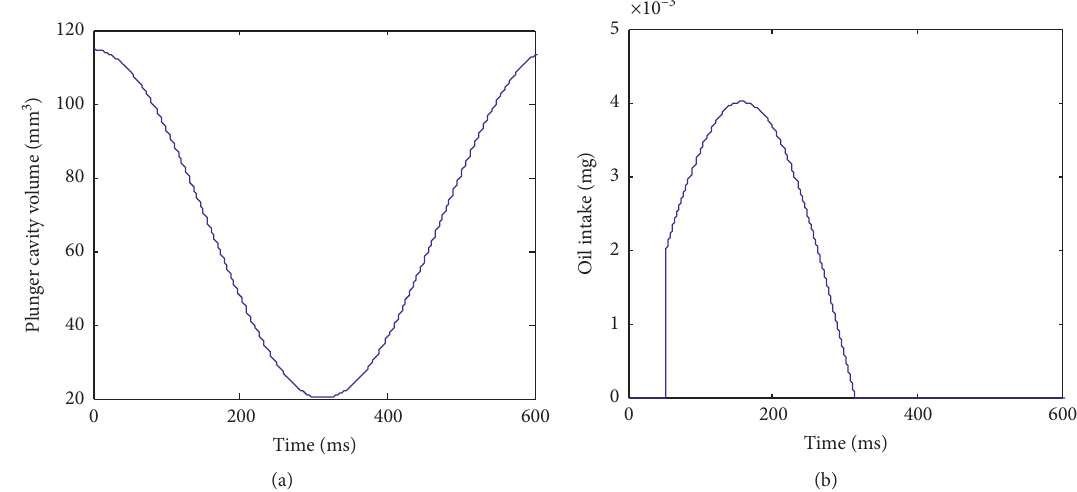
Figure 6: Changes in the volume of plunger housing and fuel inflow with time.